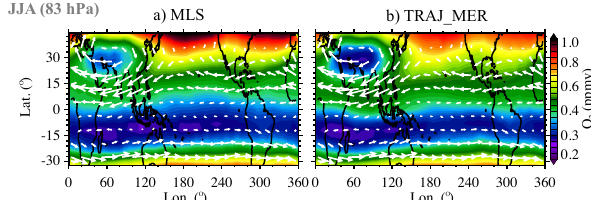
Figure 6. Northern Hemisphere summertime (JJA) tropical O 3 dis- tributions at 83hPa averaged from 2005 to 2011 between MLS and the MERRA-driven trajectory simulations (weighted by the MLS averaging kernels). Horizontal wind vectors from the MERRA re- analysis are overlaid to emphasize the Asian summer monsoon an-